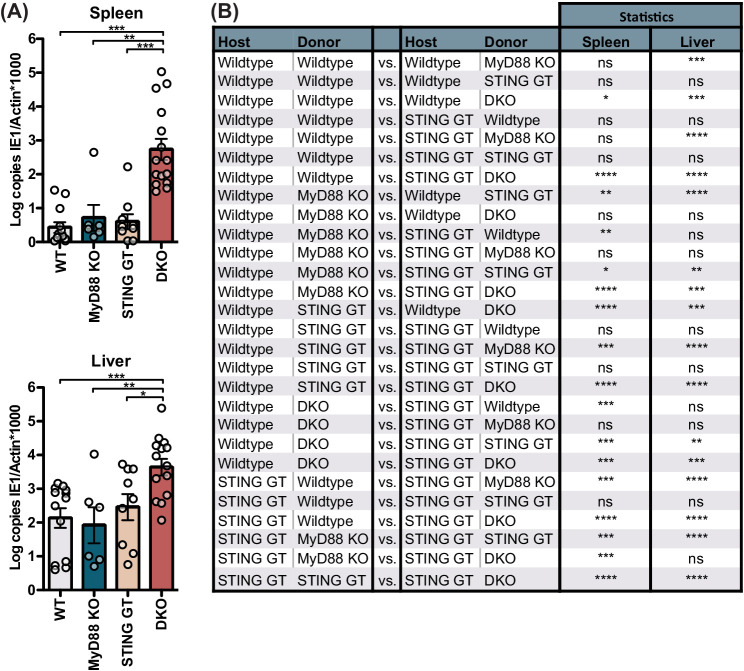
Viral load for 20,000 PFU infection 5 days p.i. and extended statistical analysis for bone marrow chimeras.(A) Mice were infected with 20,000 PFU and viral load was quantified 5 p.i. (B) Extended statistical analysis for bone marrow chimeras presented in Figure 2C. Each panel shows cumulative data of 2 independent experiments. Error bars indicate SEM; ns, not significant, *p<0.05, **p<0.01, ***p<0.001, ****p<0.0001.